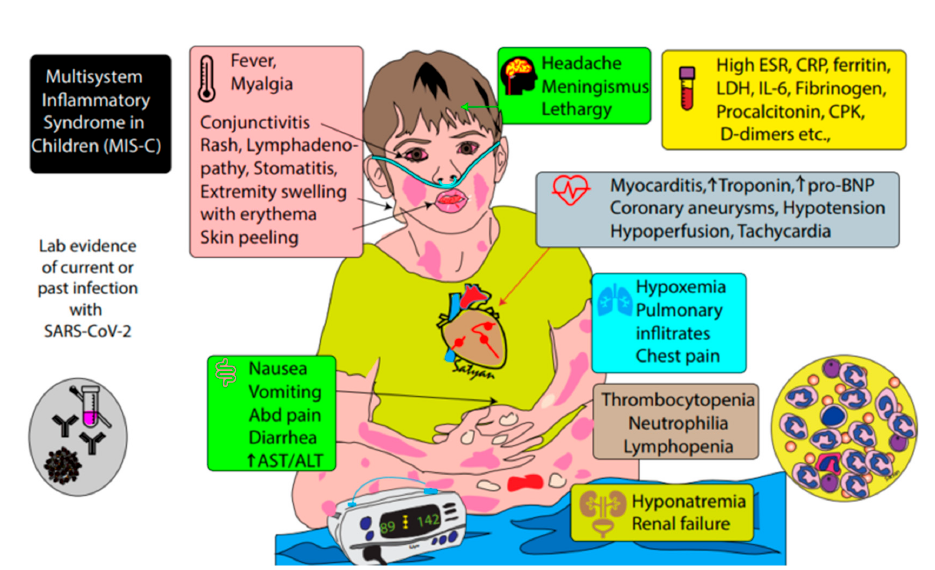
Abbreviations: CDC, Centers for Disease Control; CRP, C-reactive protein; ESR, erythrocyte sedimentation rate; LDH, lactate dehydrogenase; RT-PCR, reverse transcriptase polymerase chain reaction; SARS-CoV-2, severe acute respiratory syndrome coronavirus-2.